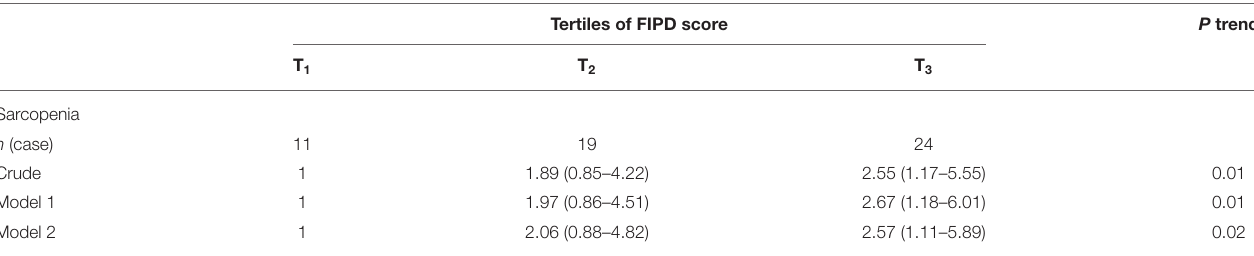
TABLE 4 | Multivariable-adjusted odds ratios (95% CIs) for sarcopenia across tertile FIPD categories.